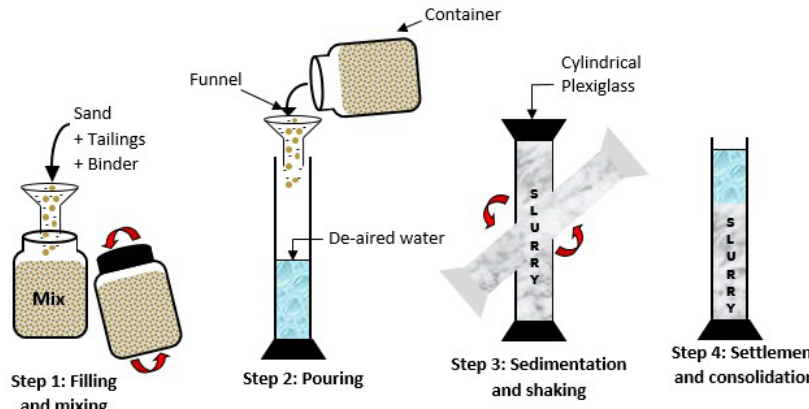
Figure 3. Illustration of the deposition method of cemented hydraulic fill (CHF) (adapted with the permission from [Carraro, J.; Prezzi, M.], [Geotechnical Testing Journal], published by [ASTM International] [69]).